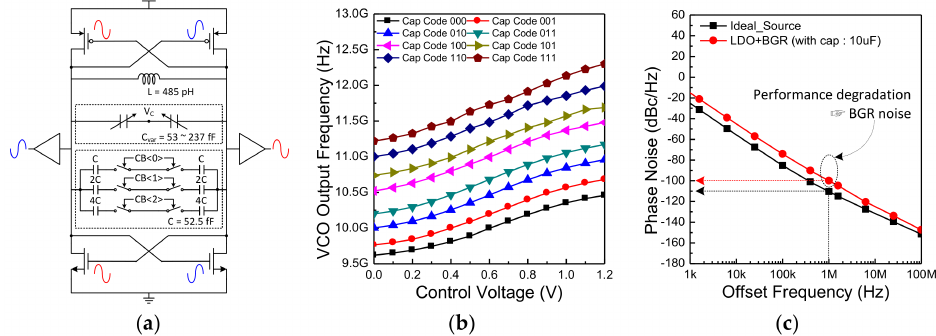
Figure 7. ( a ) A detailed schematic of the VCO used in the proposed structure; ( b ) The output frequency range is described as a function of the capacitor bank and gate voltage of the varactor; ( c ) The phase noise performance of the